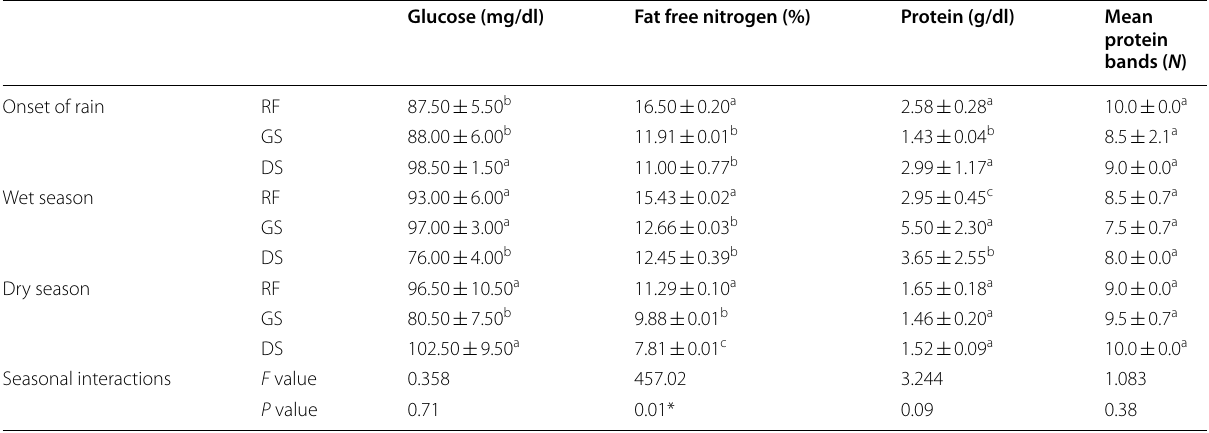
RF rainforest; GS Guinea savannah; DS derived savannah abc Means ( standard deviation) in the same column for each of the seasonal periods having similar superscripts are not significantly different at p < 0.05 ± *Interaction significant at p < 0.05